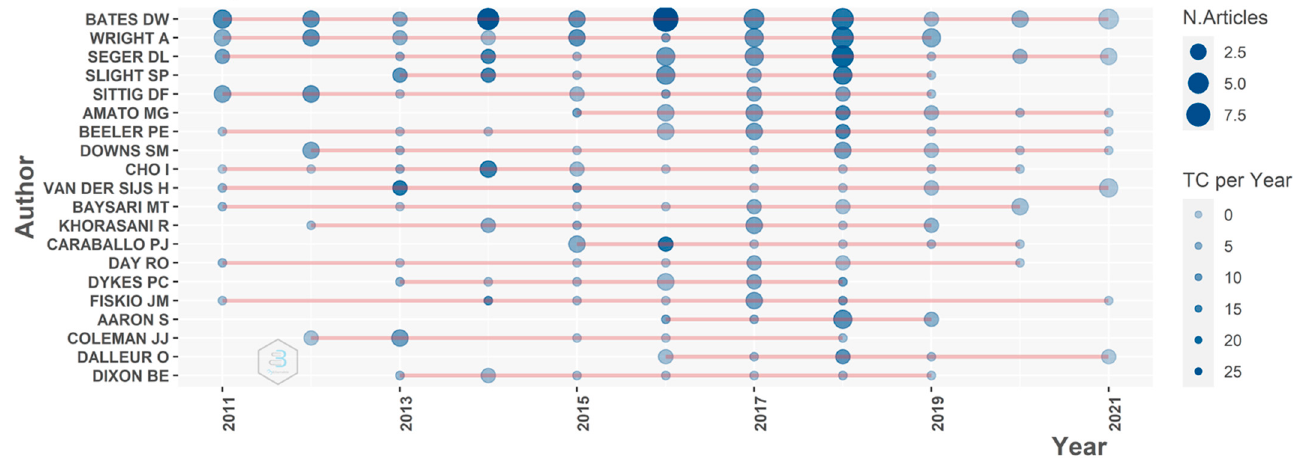
Figure 2. Top 20 authors’ publication productivity time.